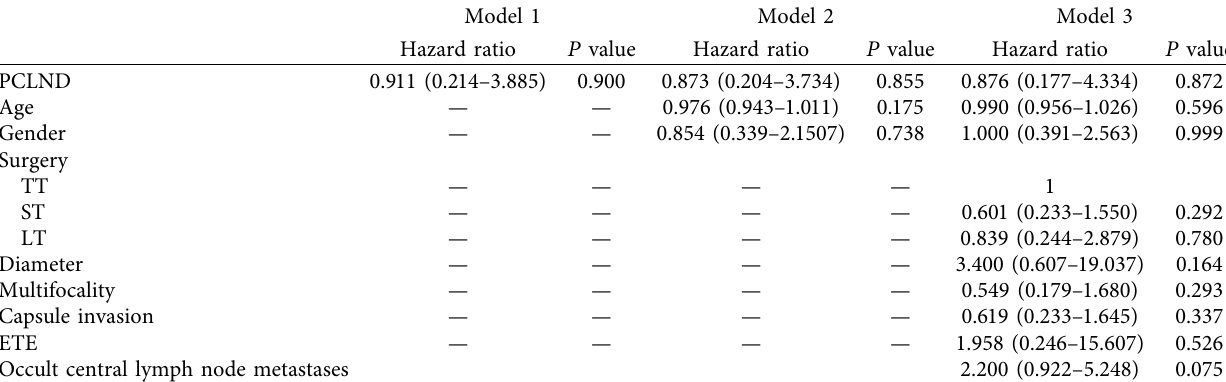
Table 4: Cox regression models of association between PCLND and